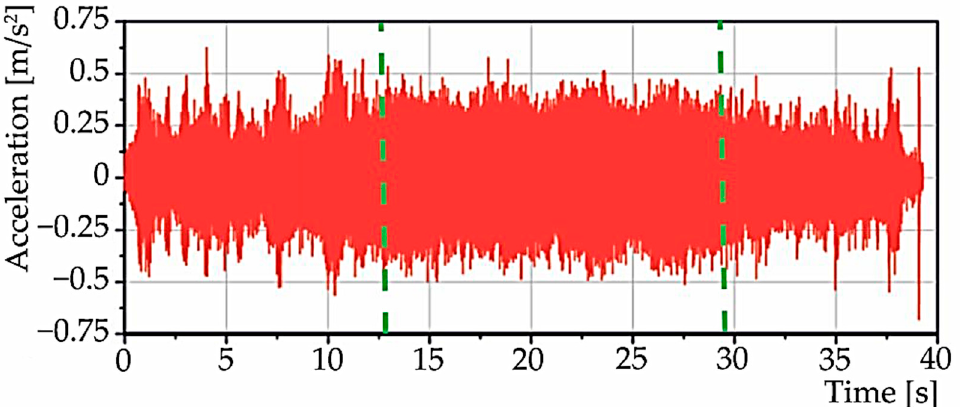
Figure 14. Time waveform of the signals when the machine spindle starts to accelerate (simultaneous data acquisition).